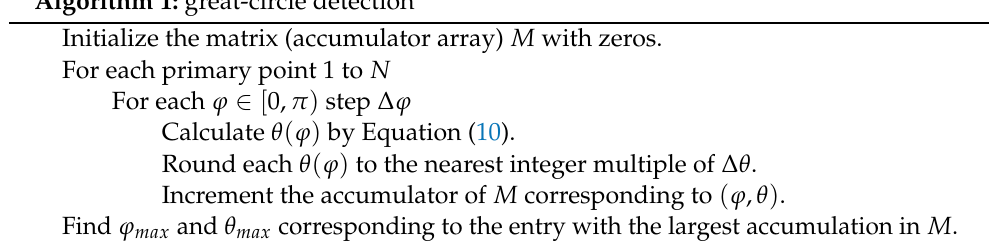
Algorithm 1: great-circle